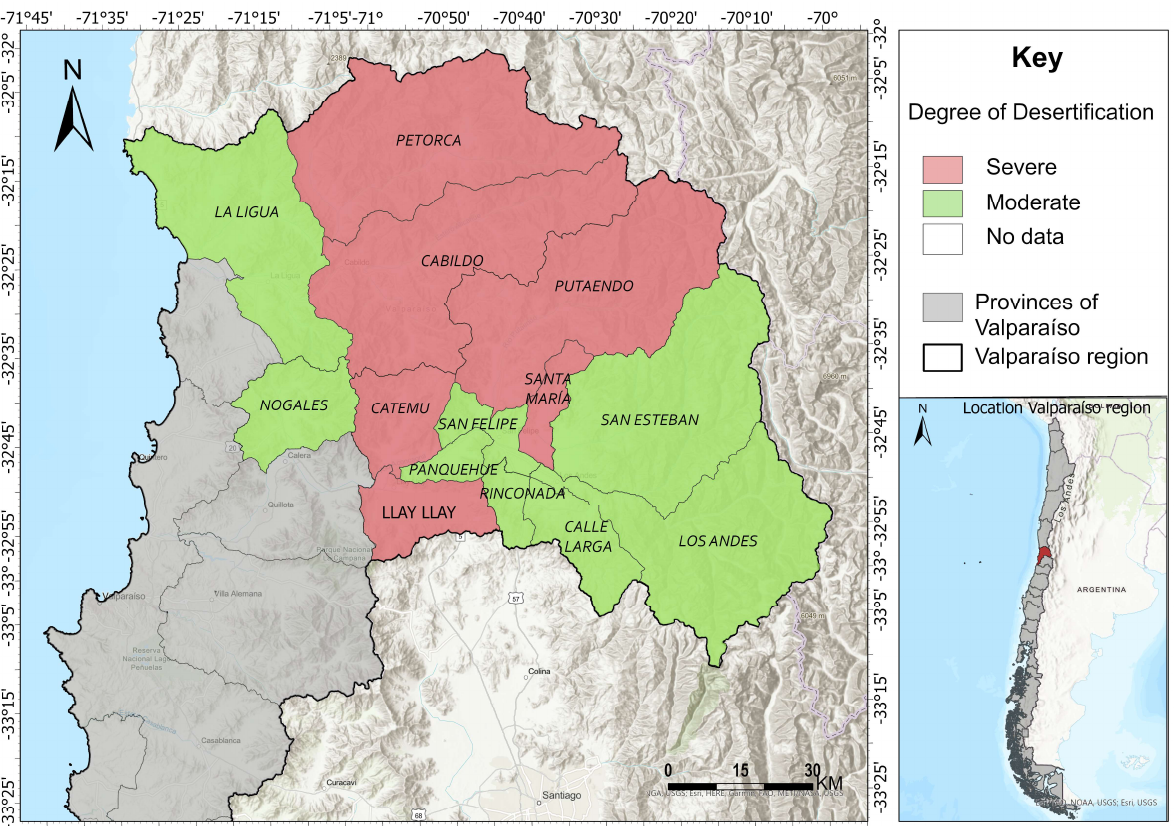
Figure 4. Change in land use in the period 1997, 2013, 2017. Based on data from the National Forestry Corporation CONAF.